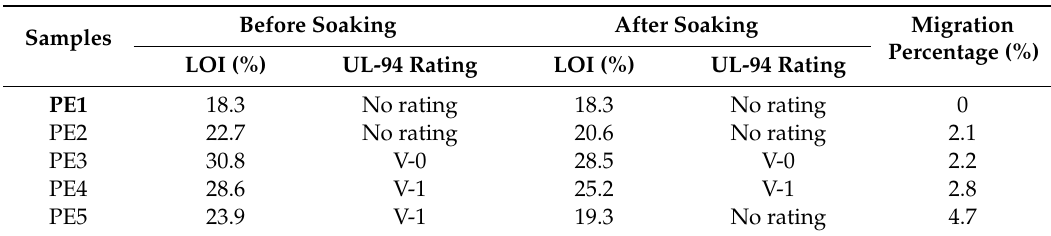
Table 2. Limiting oxygen index (LOI) and UL-94 vertical test results of HDPE / IFR composites before and after soaking.